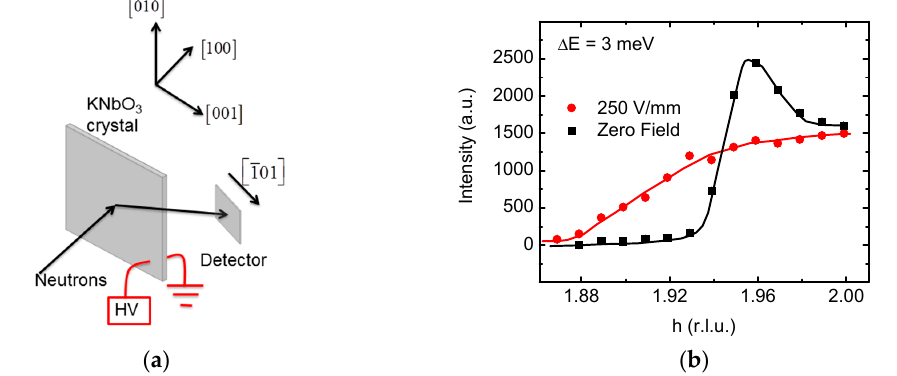
Figure 9. ( a ) Schematic illustration of in situ measurement of phonons in a crystal under applied electric fields. The geometry of the crystal is the same, as shown in Figure 6. The transverse acoustic modes propagating along 101 direction were measured around the (202) ZC with a moving detector. This set up enables investigation of the effect of increased correlation length for B-atom displacements on transverse phonon propagation. ( b ) The dampening of the phonons, observed from a broadening of the inelastic neutron scattering peak, indicate increased lattice instability and hence greater susceptibility to mechanical deformation under field. After Pramanick et al. [57] Reprinted from reference [57], with permission from John Wiley and Sons.